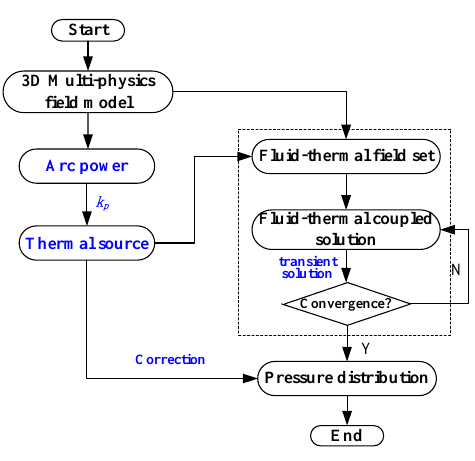
Figure 3. Flowchart of the pressure rise calculation method.